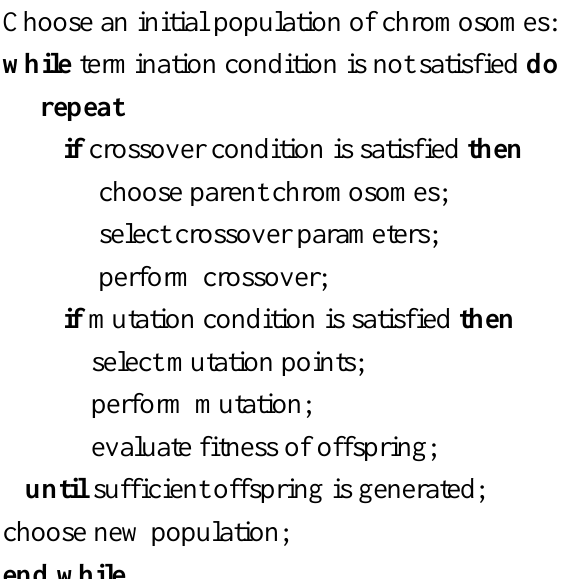
Algorithm 2 The general pseudo code of the genetic algorithm [26]